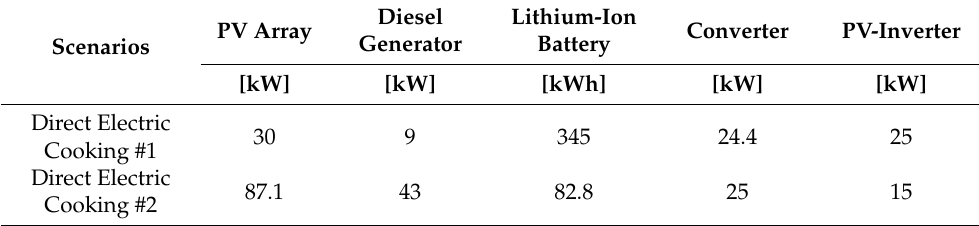
Table 4. Proposed mini-grid component sizes to enable direct